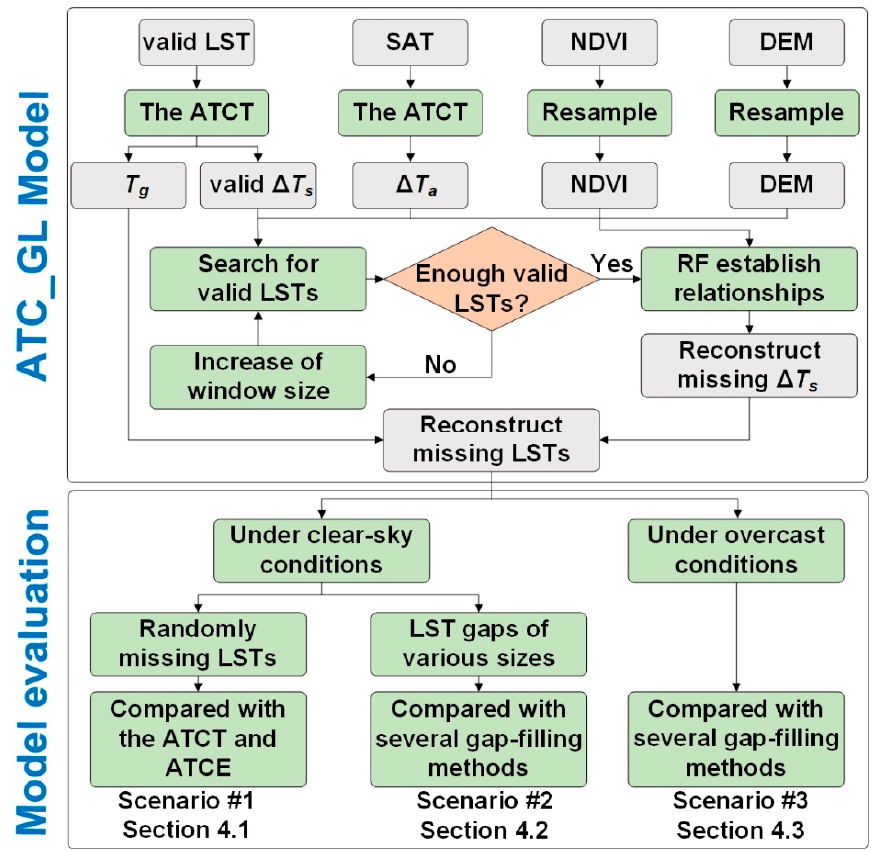
Figure 3. The flowchart of the ATC_GL and the evaluation strategies in different scenarios. T g denotes the intra-annual LST cycle dynamics, ∆ T s and ∆ T a denote the daily fluctuations in LSTs and SATs, respectively, and LST, SAT, NDVI, and DEM denote land surface temperature, surface air temperature, normalized difference vegetation index, and digital elevation model, respectively. Table 3. All the mathematical symbols and their meaning in the following formulas.